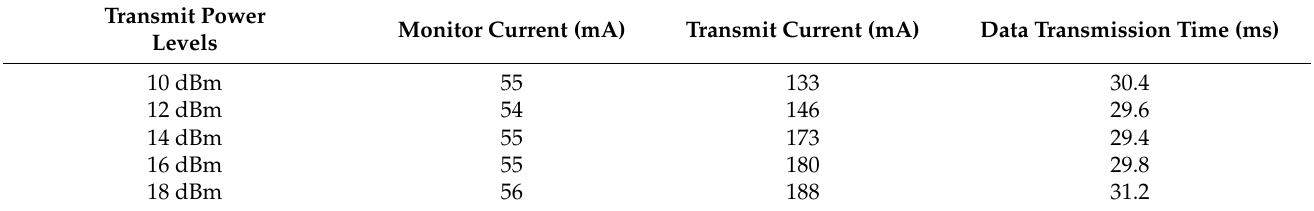
Table 3. Power consumption and transmission time under different transmit power levels.